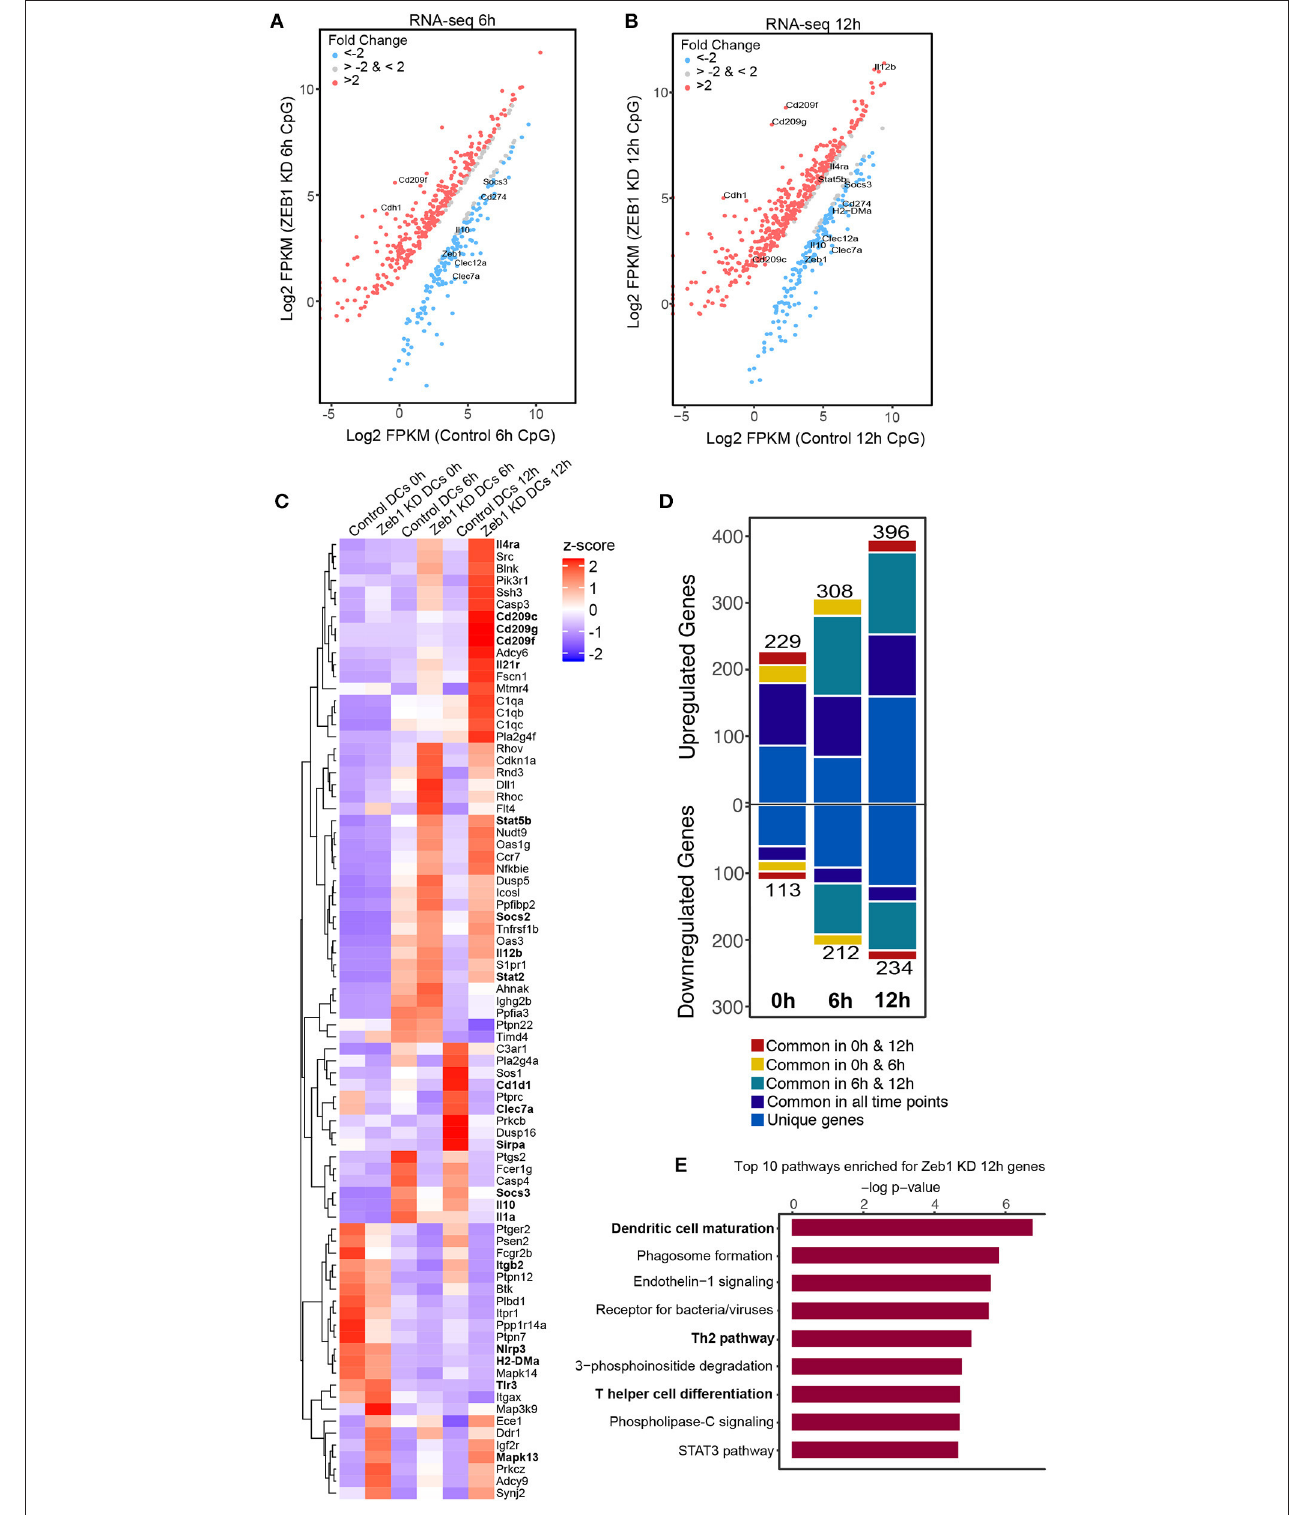
FIGURE 6 | Global transcriptome analysis of Zeb1 KD cDC1 MutuDCs showed enrichment of pathways involved in T helper cell differentiation and Th2 pathways. Two independent biological replicates with three time points (0, 6, 12h) were used for this analysis. (A) RNA-seq scatter-plot showing the differentially regulated genes in Zeb1 KD cDC1 MutuDCs as compared to control DCs at 6h after CpG activation n = 2. (B) Scatter-plot showing the differentially regulated genes in Zeb1